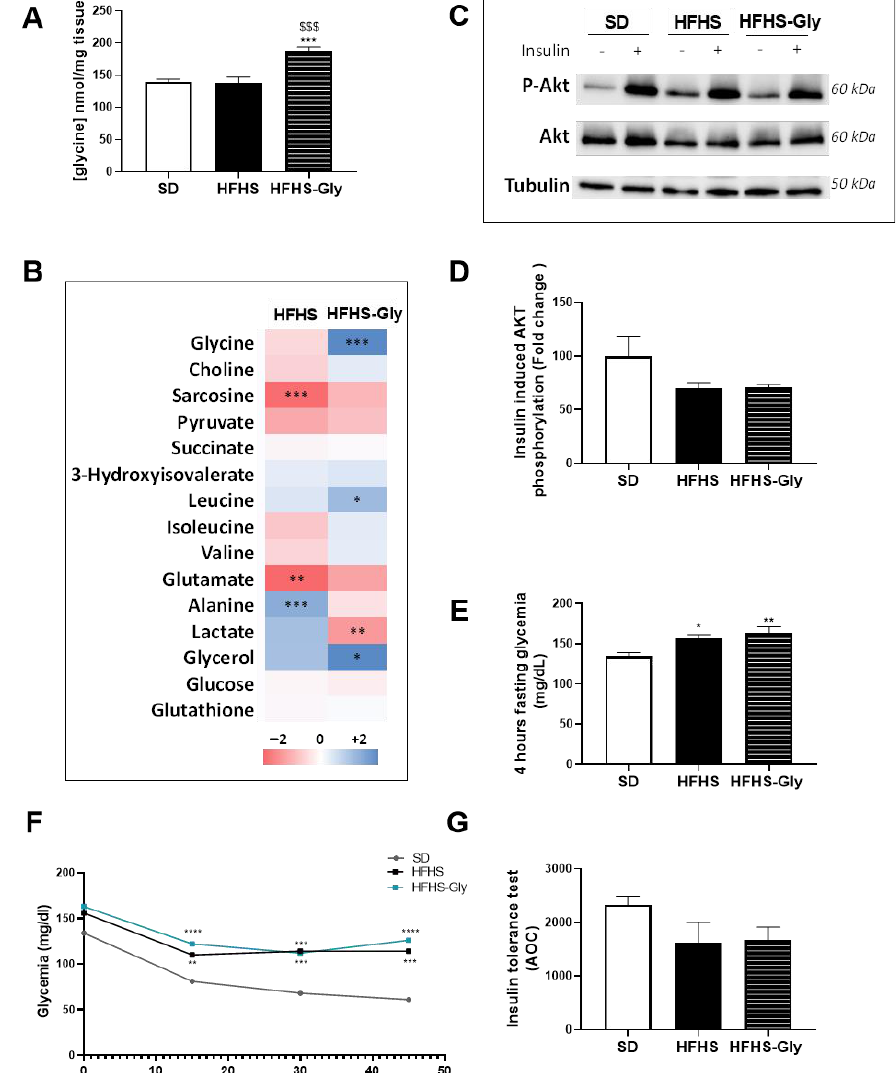
Figure 5. The impact of obesogenic diet and glycine on muscle metabolism and insulin